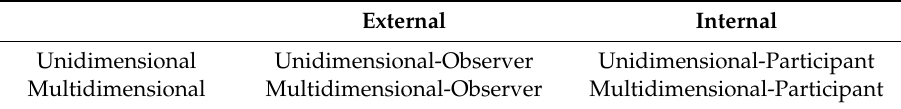
Table 2. Research approaches in the conception and investigation of self-esteem (prepared by the